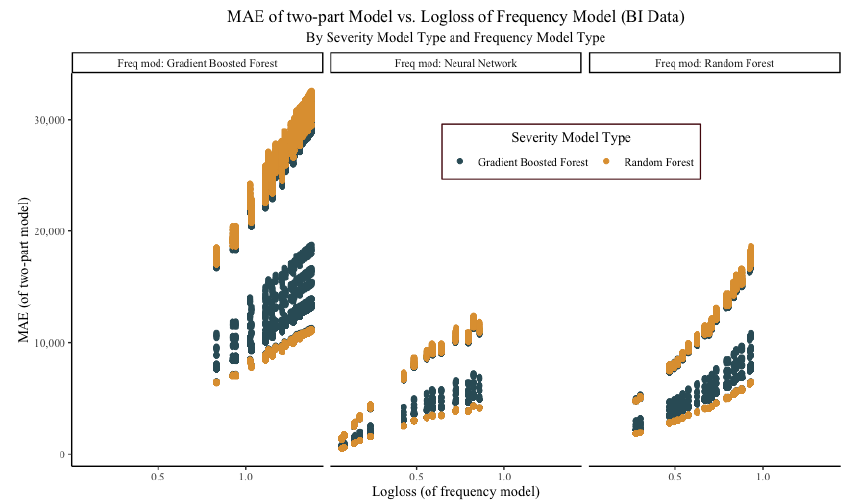
Figure 20. Comparison of the logloss of the frequency model part to the MAE of the overall two-part model for the BI data. MAE of the entire two-part model is shown on the y -axis while logloss of the frequency model is shown on the x -axis in order to illustrate how the logloss can affect the overall performance of the two-part model. Different types of frequency models are shown in each pane, while severity model types are shown by different colored points.